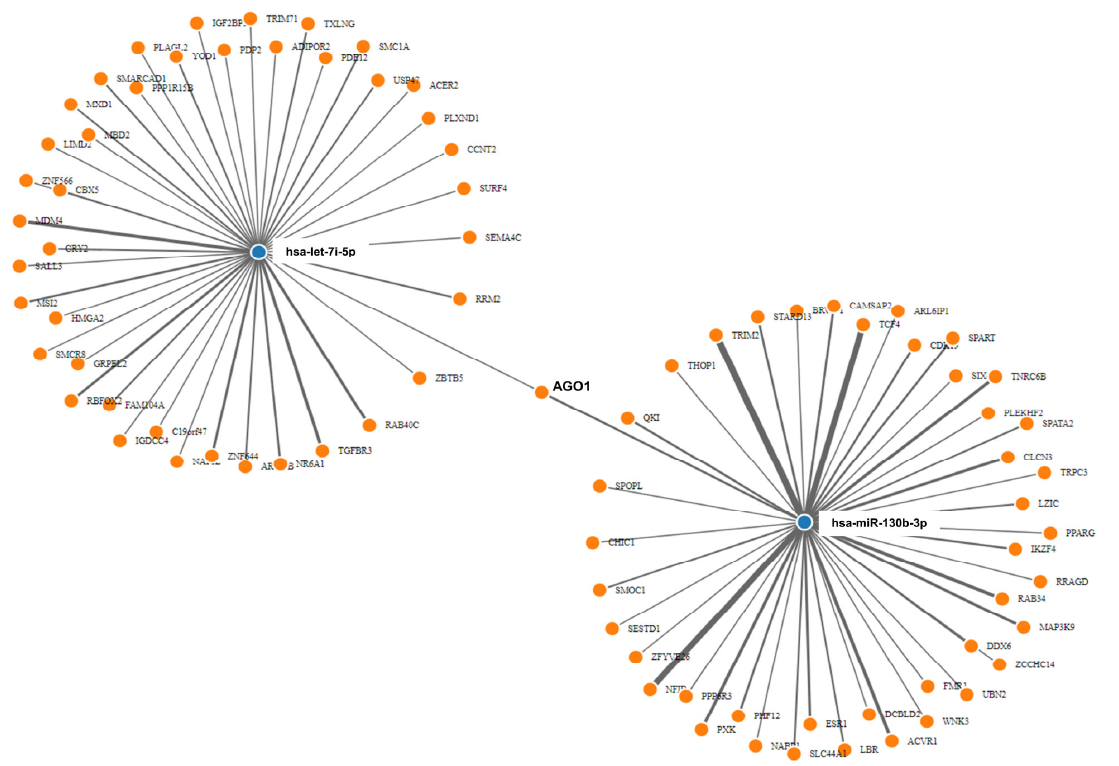
Figure 4. miRNAs–target genes interaction . Interaction network between hsa-let-7i and hsa-mir- 130b deregulated mature miRNAs and their target genes generated by MirWalk v3. Blue circles represent miRNAs, while orange circles represent mRNAs. The more connections between miRNAs and genes, the more links within the network.